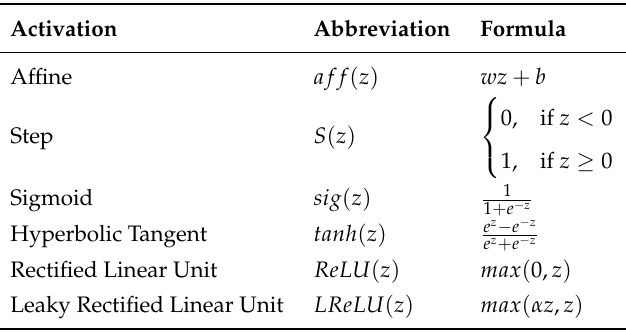
Table A2. Typical activation functions for neural networks.